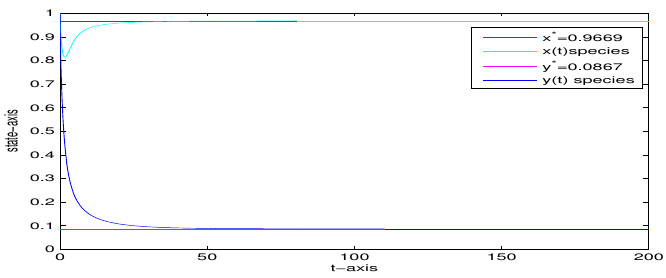
( x ∗ , y ∗ ) of model (2). 0 = 0.5714 > D = 0.0985, by use of 1 1 + fT